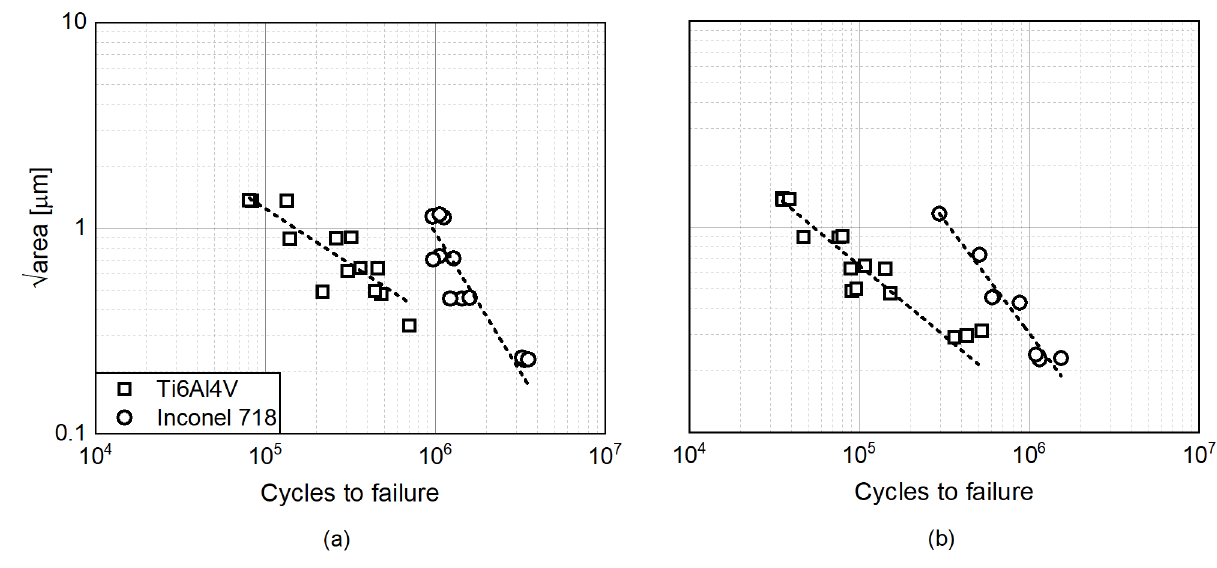
Figure 8. Influence of defects size identified by fractographic analysis on the cycles to failure for two distinct stress levels: ( a , b ).